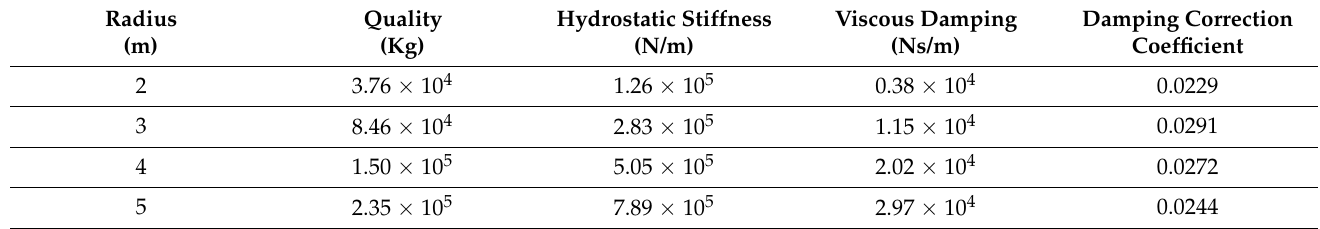
Table 2. Basic parameters for viscosity correction of floaters with different radii.